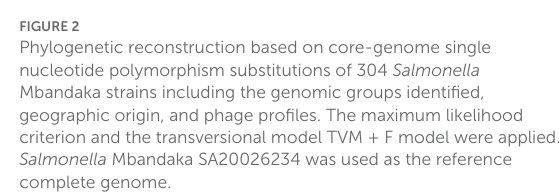
FIGURE2 Phylogenetic reconstruction based on core-genome single nucleotide polymorphism substitutions of 304 Salmonella Mbandaka strains including the genomic groups